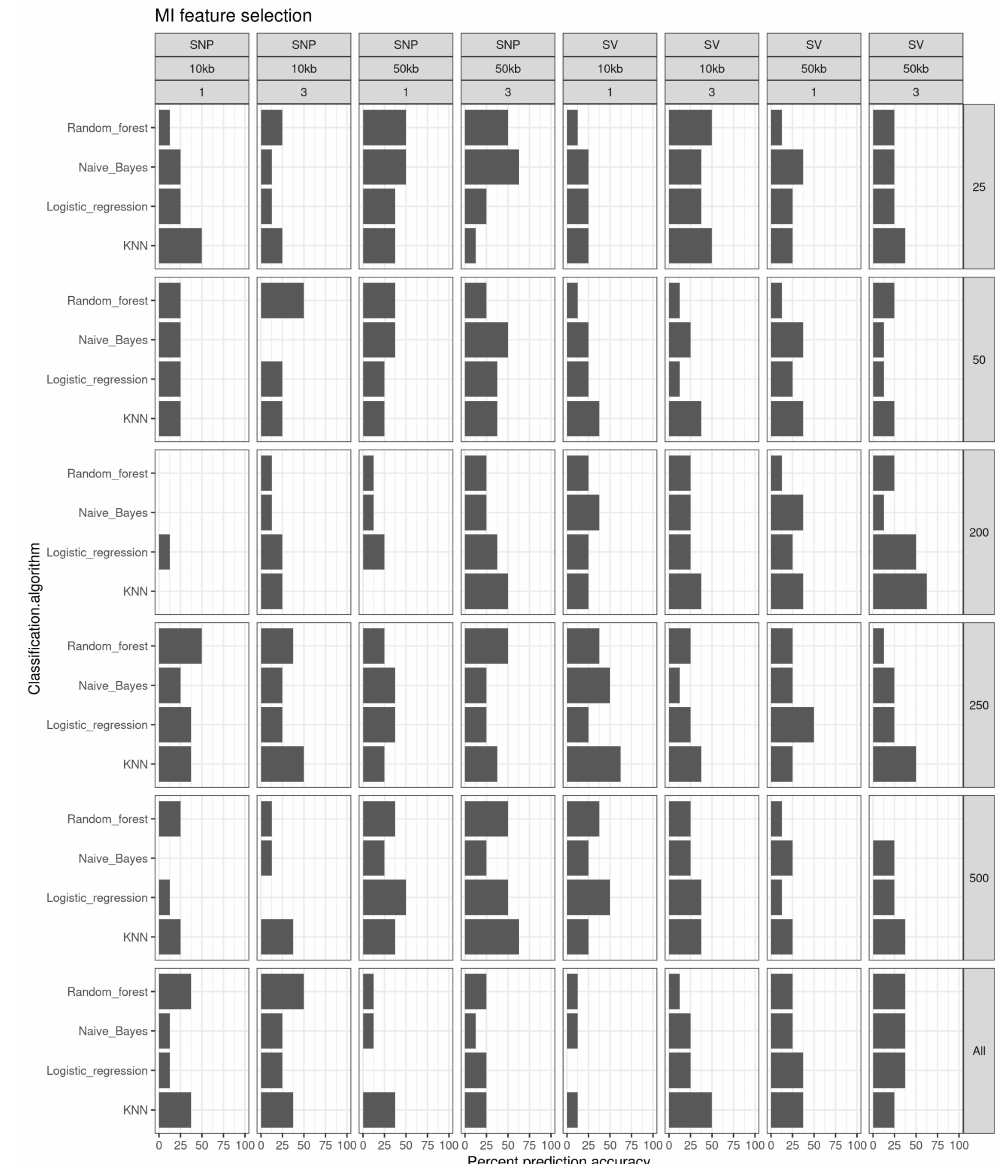
Figure 5. Prediction accuracy (%) for the different feature selection sets of classification algorithms using a mutual Information feature selection